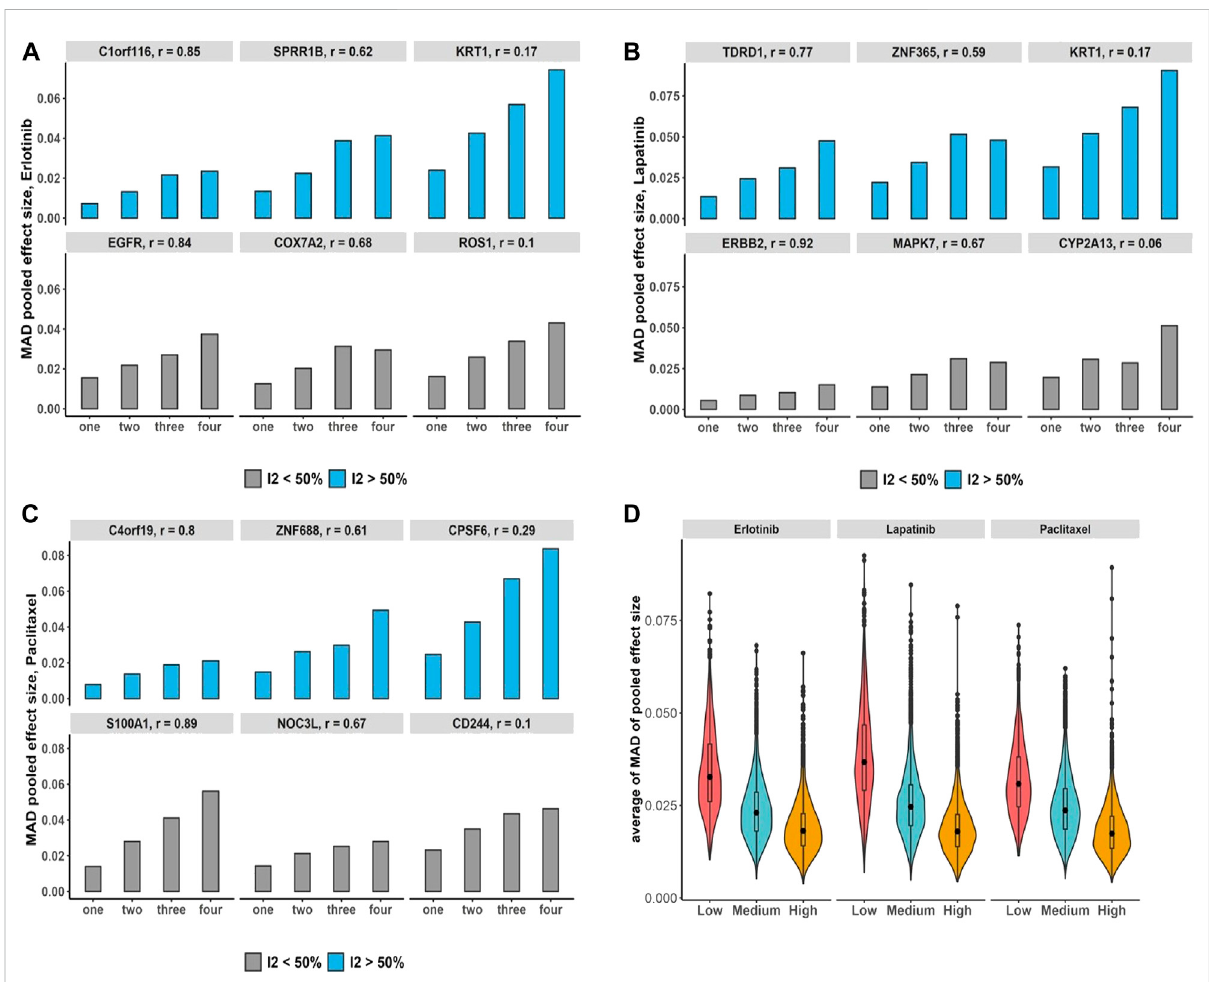
FIGURE 6 Pan-cancernon-independentmeta-analyses: (A – C) barplotsdemonstrateincreasesinthenumberofduplicationsanditsimpactonthebiasof estimated overall effect using MAD metric across drugs and selected genes with substantial (blue) and non-substantial (gray) estimated heterogeneity estimation. Note that x -axis presents the number of duplicate study effects. (D) Violin plots show average of MAD values across non- independent meta-analyses per genes over median of Pearson correlation of each gene ’ s expression across studies: low (| r | < 0.3), medium (0.3 ≤ | r | < 0.7), and high (| r | ≥ 0.7). Black dot at the box plot represents the